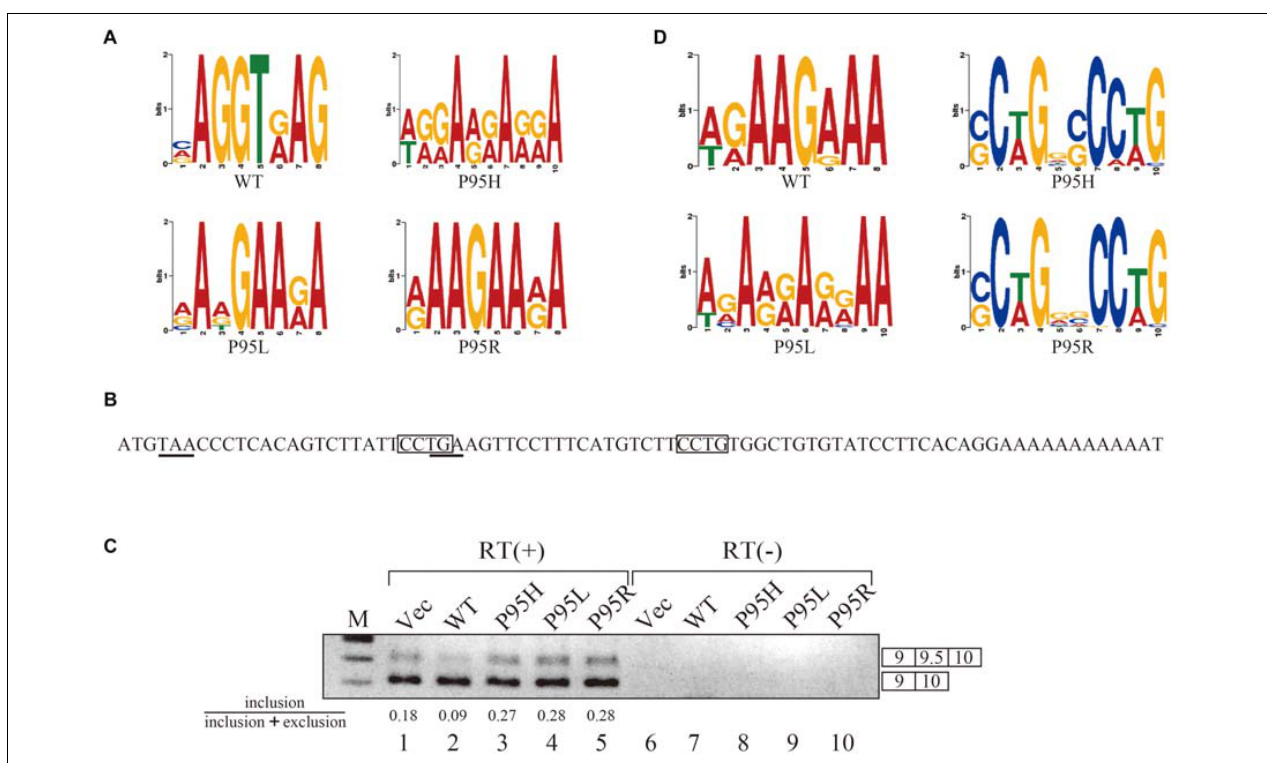
FIGURE 3 | SRSF2 mutants promote exon 9.5 of EZH2 gene through binding to CCWG motif. (A) Sequence logos for the motifs enriched in inclusion-type exons with WT, P95H, P95L, and P95R are presented. (B) Sequence logos for the motifs enriched in inclusion-type exons with WT, P95H, P95L, and P95R are shown. (C) Sequence of exon 9.5 (pseudo exon) in human EZH2 gene. In frame stop codons are underlined. CCWG motif, found with SRSF2 P95H and P95R proteins in (B) , are indicated with open boxes. (D) Splicing pattern of EZH2 pre-mRNA in myc-vector, SRSF2 WT, P95H, P95L, and P95R are indicated. The ratio of exon9.5 included product in total splicing products is shown beneath the panel. The schematic representations of PCR products are shown at the right side of the panel. RT, Reverse Transcriptase. M, DNA size marker.